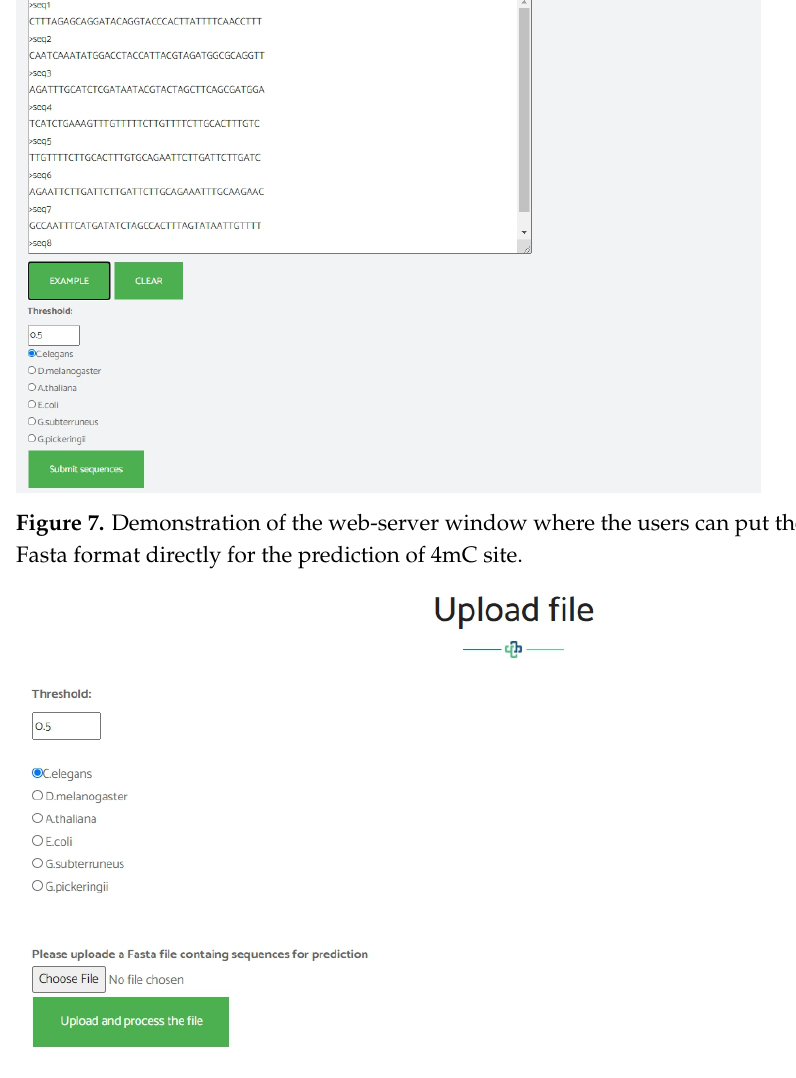
Figure 8. Demonstration of the web-server window where the users can upload the DNA sequence in the Fasta